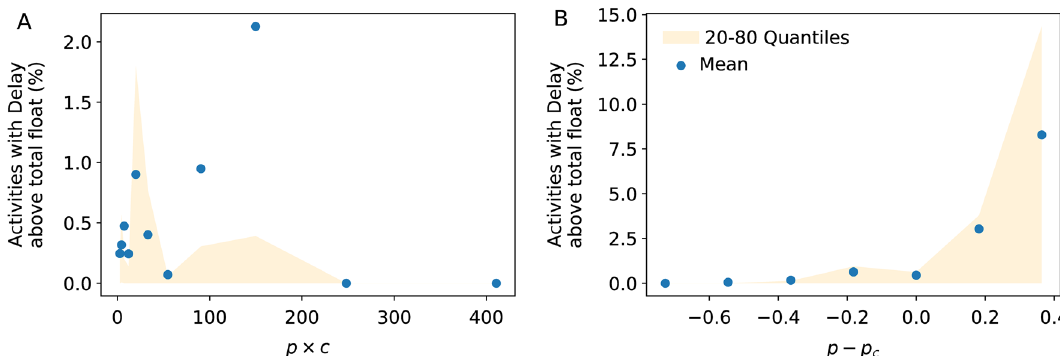
Figure 5. Delay incidence. ( A ) Observed delay incidence in construction projects as a function of p × c, control parameter associated with the critical path. ( B ) Observed delay incidence in construction projects as a function of p - p c , the control parameter of percolation theory. p is the fraction of delay transmissions along direct activity- activity relations, c the number of activities in the critical path and p c is the critical threshold from percolation theory ( p c = 1/ < k